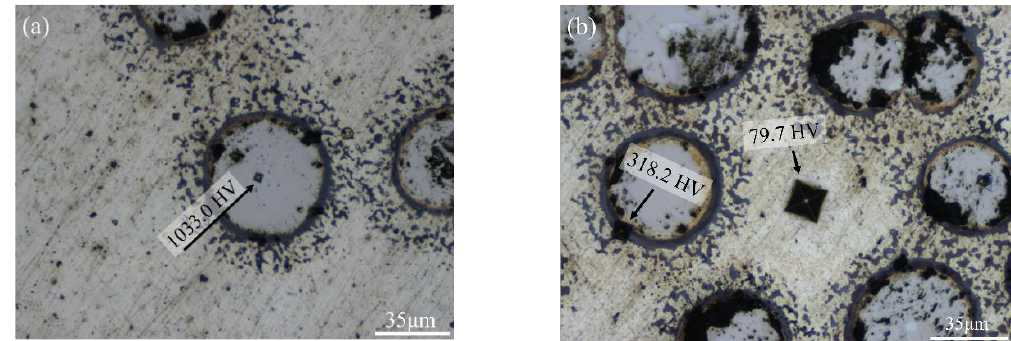
Figure 7. ( a ) LM micrograph of the indentation location in center of the T2N8-950 titanium nitride particles. ( b ) LM micrograph of the indentation location in the T2N8-950 nickel matrix and oxygen-rich film.